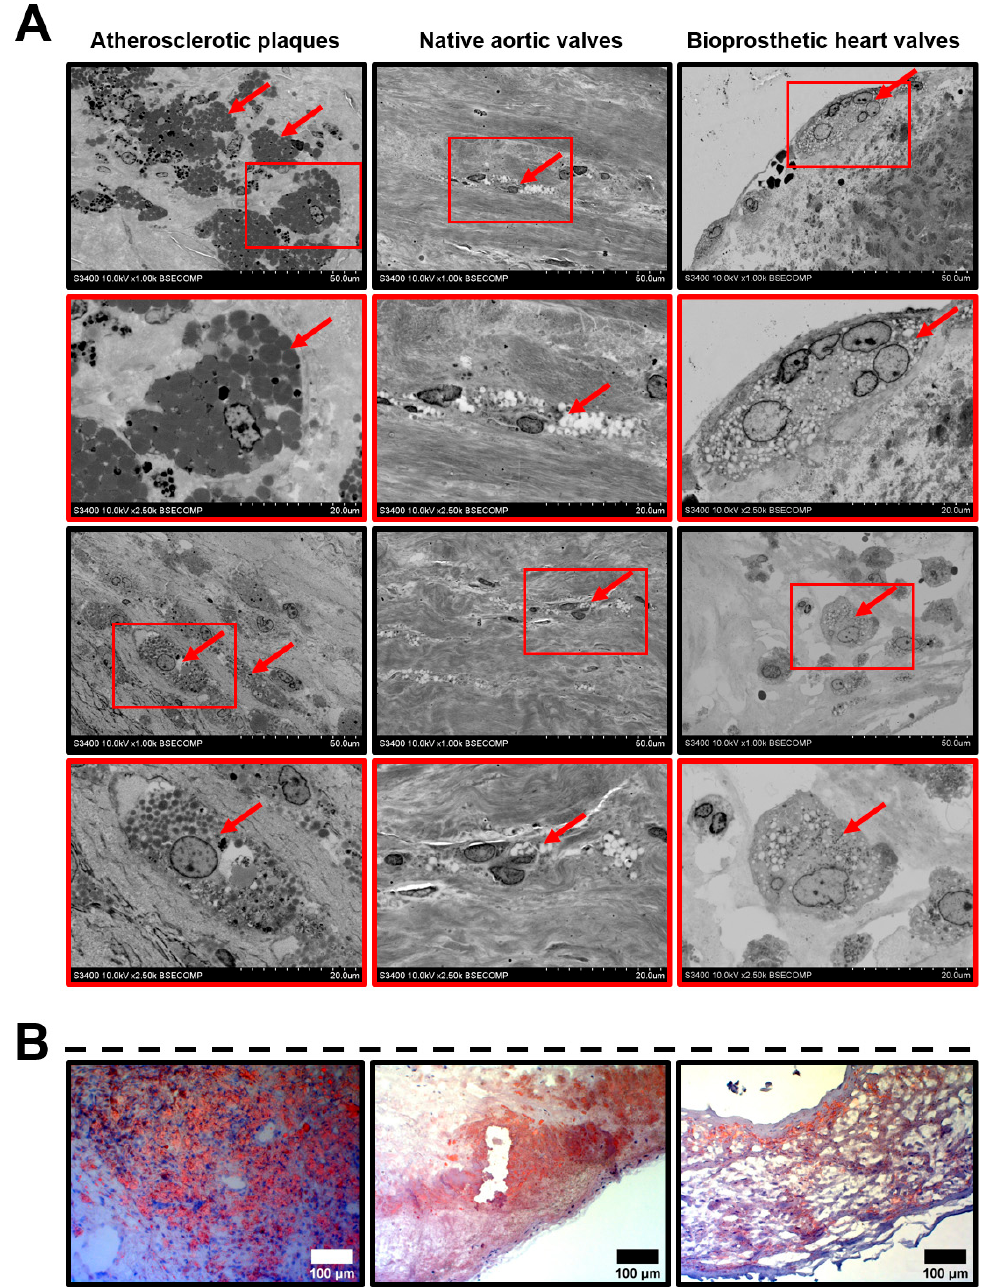
Figure 1. Lipid-laden macrophages (foam cells, indicated by red arrows) within the atherosclerotic plaques, calcified native AVs, and failed BHVs. ( A ) Different appearances of the lipid-laden macrophages depending on their location and phenotype, backscattered scanning electron microscopy, magnification 1000×–2500×. ( B ) Oil Red O staining of foam cells, magnification 200×. Note the multiple clusters of foam cells in the atherosclerotic plaques, as well as the fatty streaks beneath the surface of native AVs and BHVs, which, however, contained only single foam cells in the deep tissue